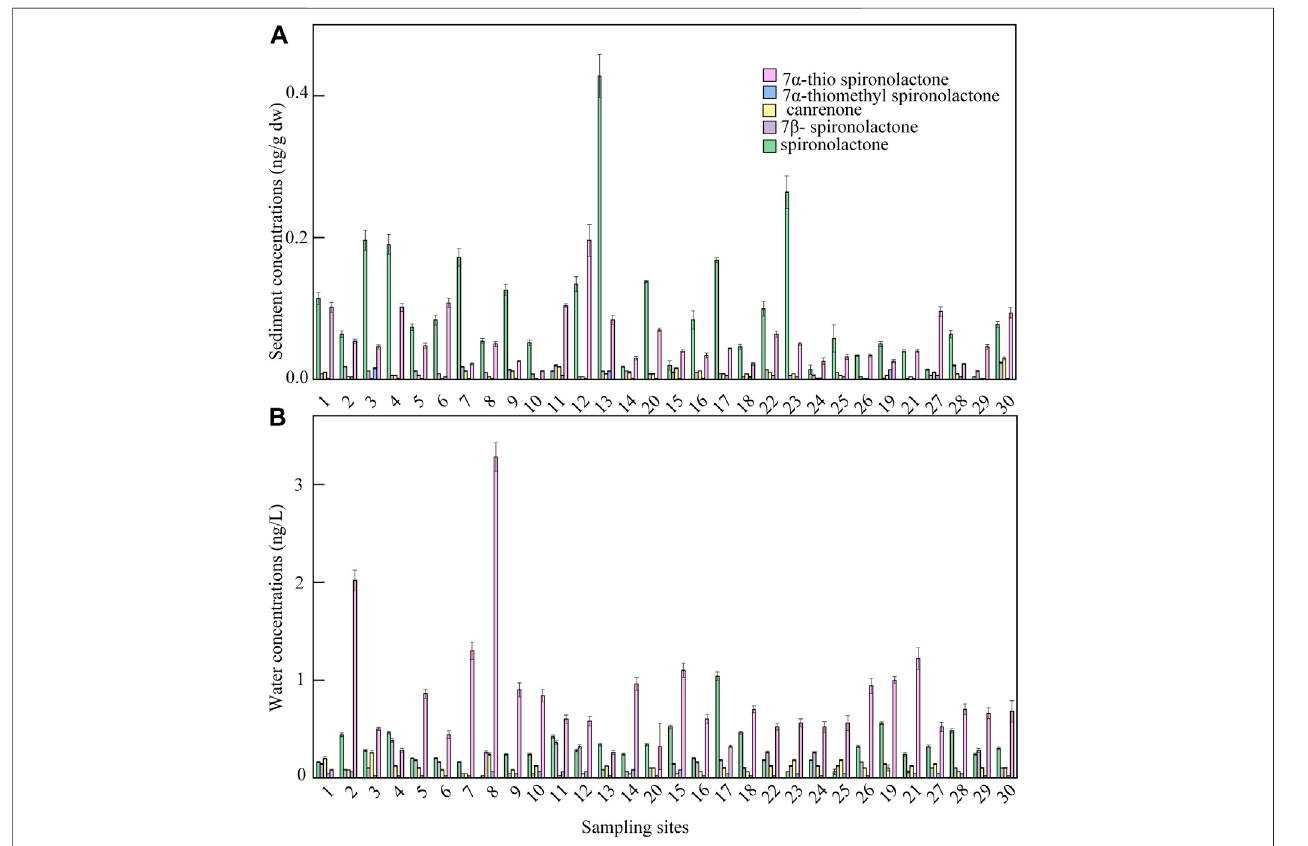
FIGURE 6 | Concentration variations of spironolactone and its four metabolites in sediment (A) and water (B) samples from Taihu Lake. Error bars represent SD values of two duplicate composite samples.